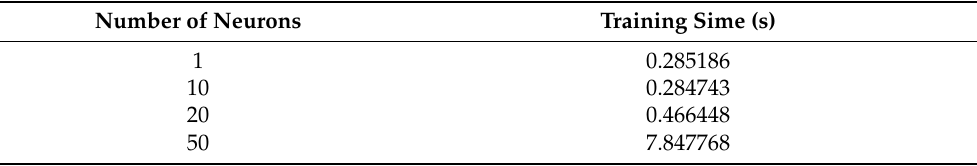
Table 15. Relationship between number of neurons and training